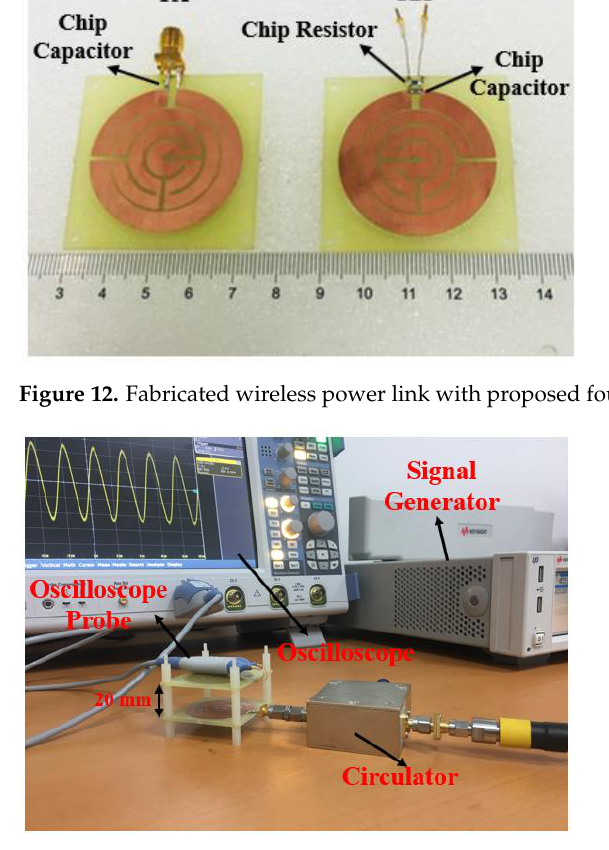
Figure 13. Measurement setup of wireless power link with proposed four-turn split-ring loops.